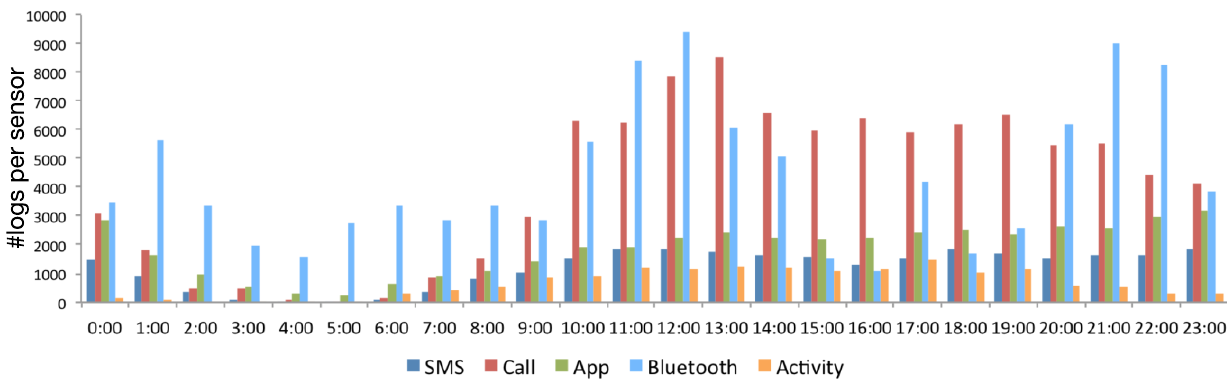
Figure 3. Overview of five sensor data for all users collected in mobileStd 2 based on time of the